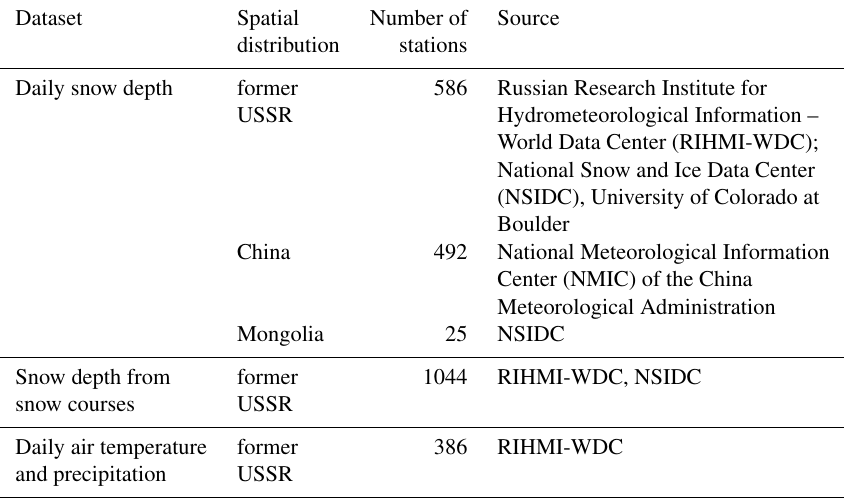
Table 1. Sources of snow depth